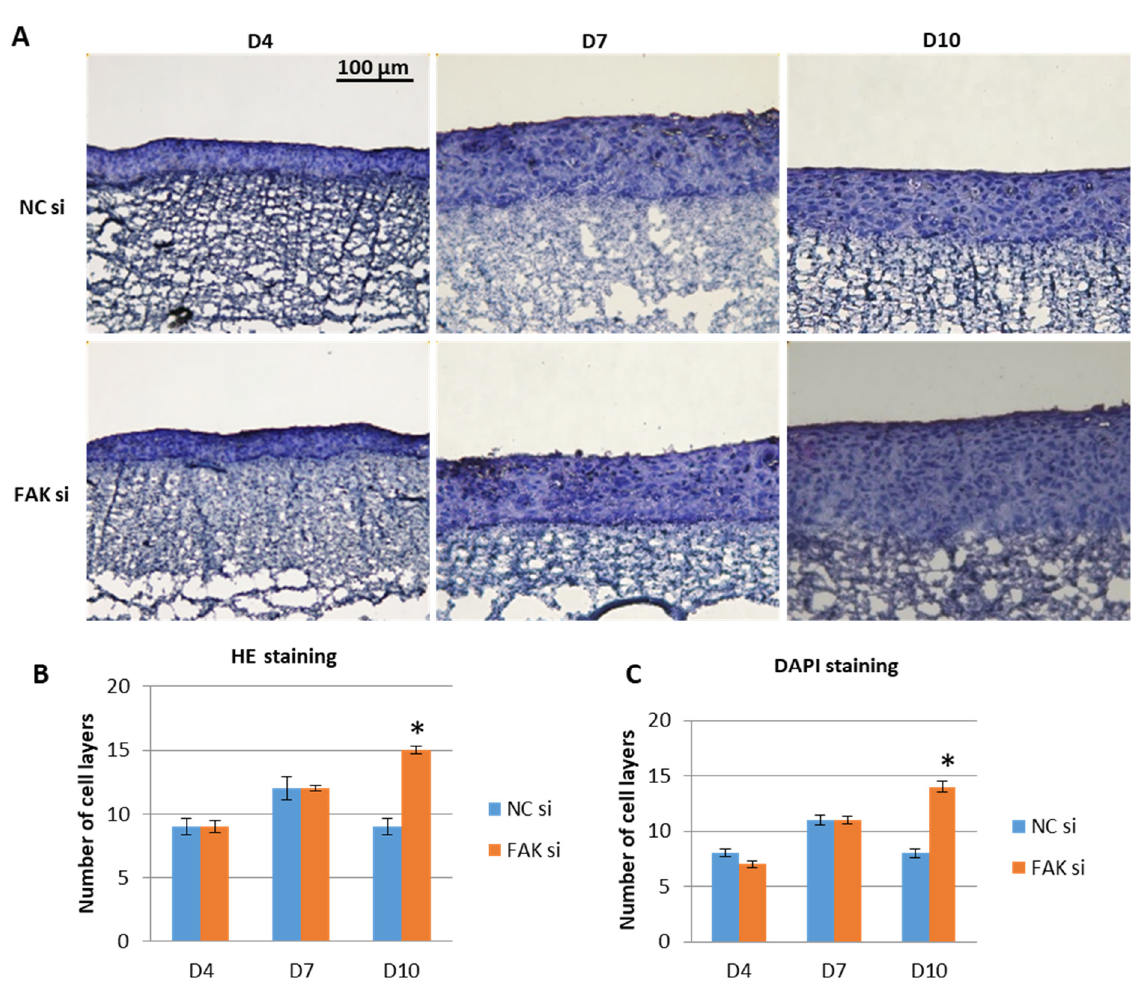
Figure 2. siRNA-mediated inhibition of FAK in GK-based cocultures. Cells were transfected with FAK-siRNA and incubated for 48 h before usage in the coculture setup for a further 4, 7, or 10 days. Shown in ( A ) are representative cryofixed and HE stained sections of FAK-siRNA-treated versus nontreated cocultures at the indicated points of time. The number of cell layers were counted manually in the HE sections, and the corresponding statistical analysis is shown in ( B ). DAPI stained sections were also evaluated for the number of cell layers and analyzed statistically as shown in ( C ). Bar graphs illustrate the increase in the number of cell layers over time and depict the statistically significant difference of FAK-siRNA-inhibited cocultures versus the noninhibited control at day 10. ( n = 3 for all experiments, values are depicted as mean ± SEM; * = p < 0.05. Scale bars represent 100 µ m. NC = negative control; D =